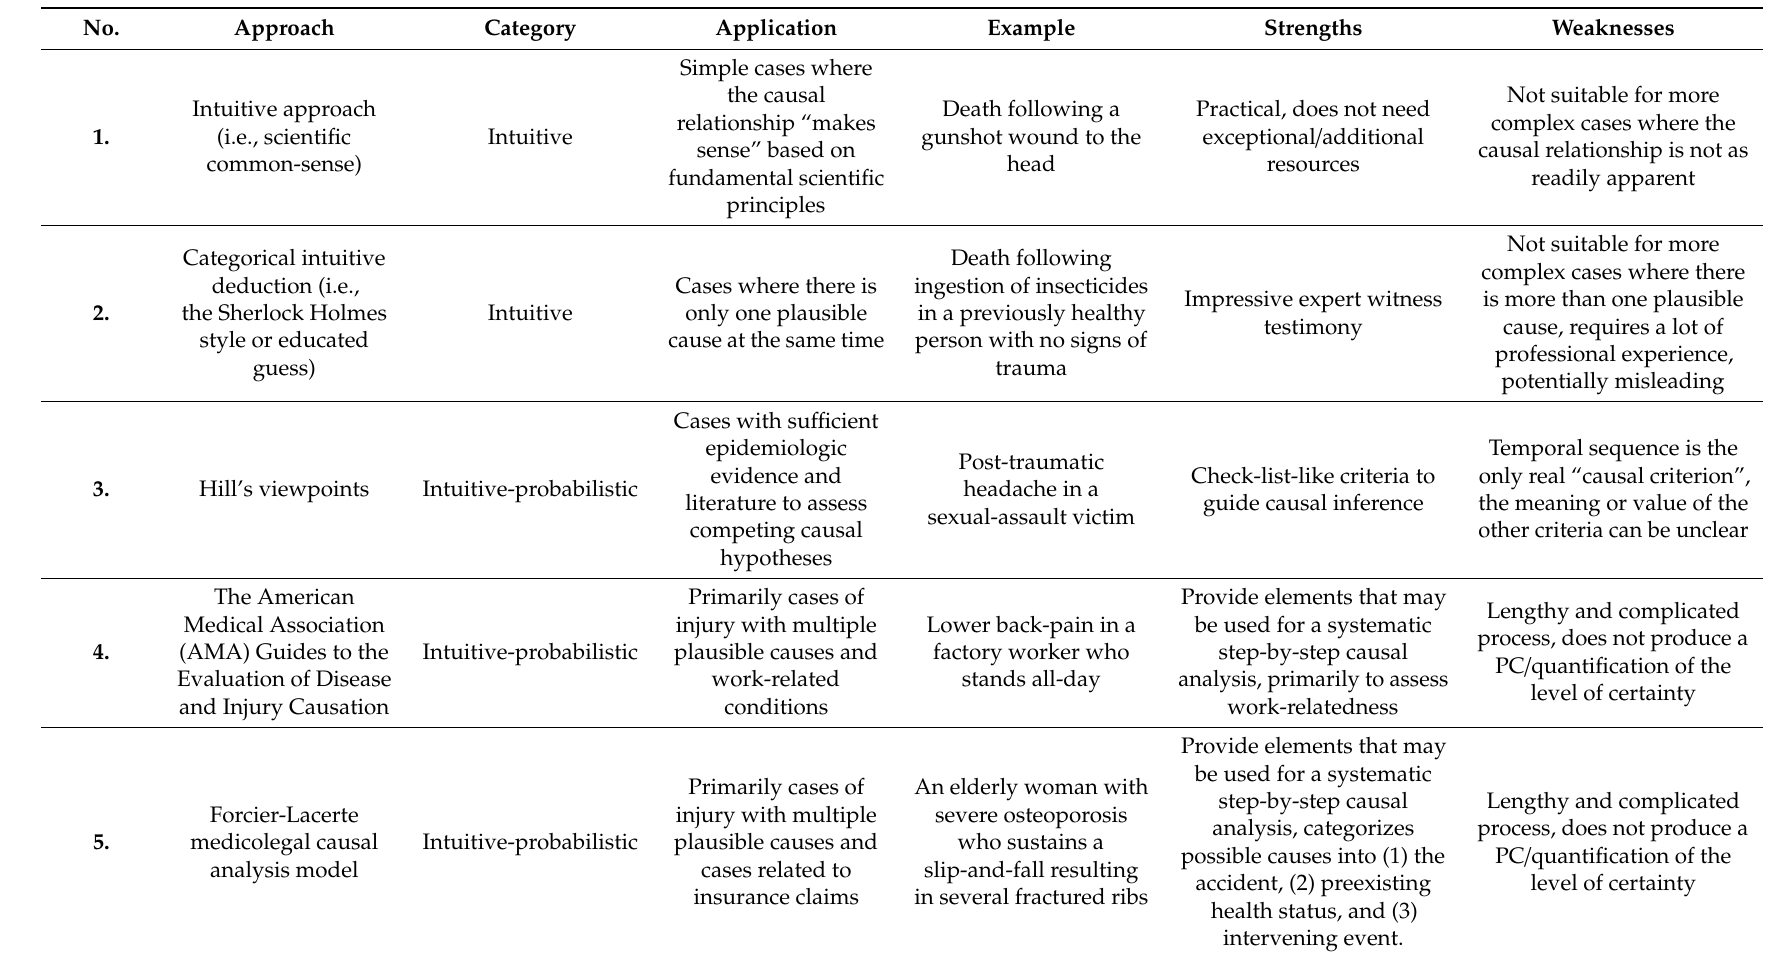
Table A1. Current approaches to medicolegal causal analysis